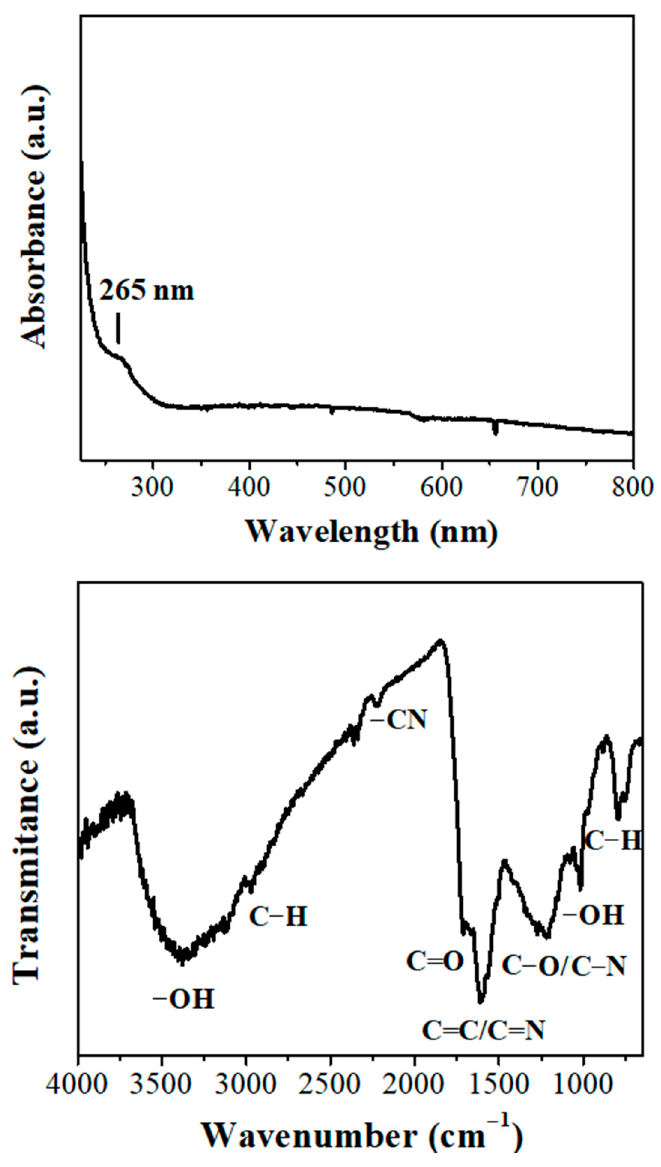
Figure 5. Ultraviolet (UV)-vis ( top ) and attenuated total reflectance infrared spectrum (ATR-IR) ( bottom ) spectra of carbon nanosheets.